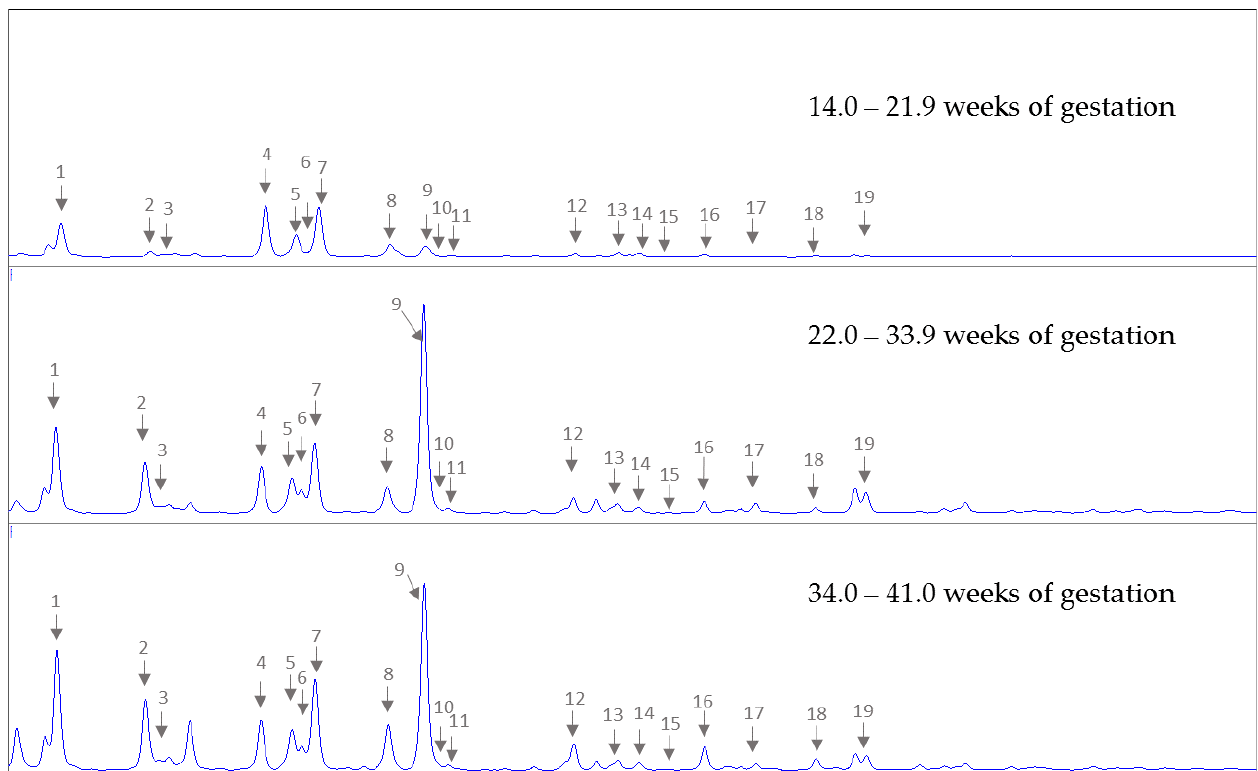
Figure 1. Representative chromatograms of pooled AF sampled at different periods during pregnancy. Eight samples each from between 14.0 – 21.9 weeks ( upper panel ), 22.0 – 33.9 weeks ( middle panel ) or 34.0 – 41.0 weeks of gestation ( lower panel ) were worked up and pooled for HPLC analysis. (1) lactose; (2) 2′ - fucosyllactose (2′FL); (3) 3 -fucosyllactose (3FL); (4) internal standard; (5) 3′ -si alyllactosamine (3′SLN); (6) difucosyllactose (LDFT); (7) 3′ - sialyllactose (3′SL); (8) 6′ - sialyllactosamine (6′SLN); (9) 6′ -sialyllactose ( 6′ SL); (10) lacto-N-tetraose (LNT); (11) lacto-N- neotetraose (LNnT); (12) lacto-N-fucopentaose (LNFP1); (13) lacto-N-fucopentaose (LNFP2,3); (14) sialyl-lacto-N-tetraose (LST)a; (15) LSTb; (16) LSTc, (17) lacto-N-difucohexaose (LNDFH); (18) lacto-